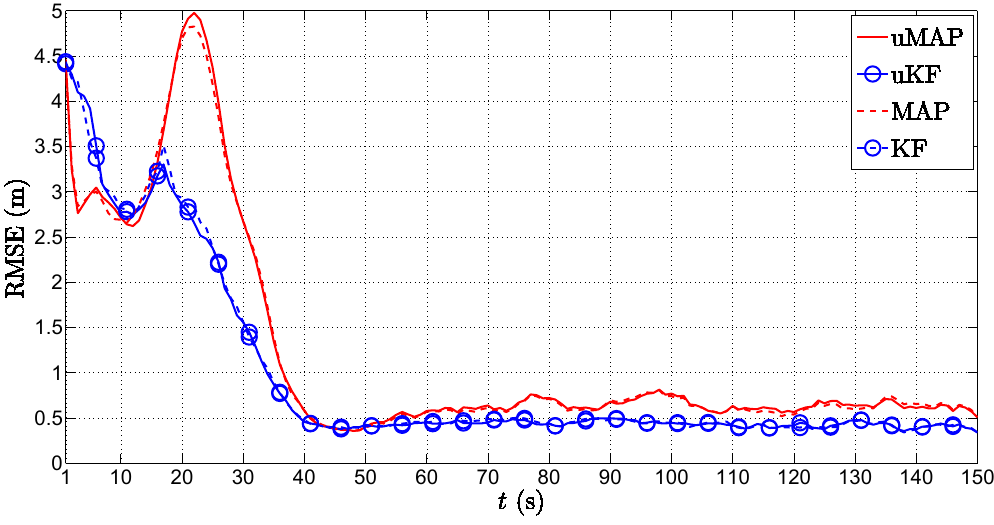
Figure 10. RMSE (m) versus t (s) comparison in the second scenario, when N = 2, (cid:107) v a (cid:107) = 1 m/s, = 9 dB, σ m = 4 π σ n rad, γ = 3, γ i ∼ U [ 2.7,3.3 ] , τ = 5 m, P 0 = − 10 dBm, q = 2.5 × 10 − 3 m 2 /s 3 , 180 i i M c = 1000.